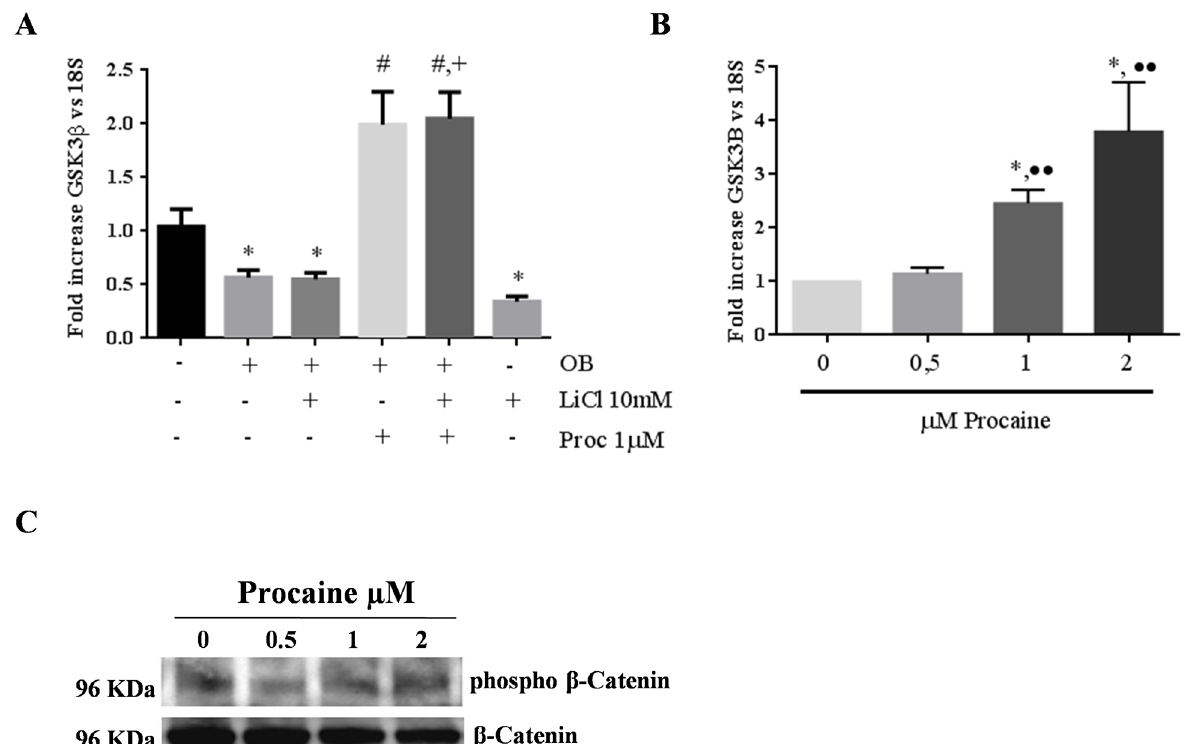
Fig 5. Mechanism of action of procaine. Changes in mRNA expression of GSK3 β from undifferentiated mesenchymal stem cells (UC), MSC differentiated into osteo/odontoblast (OB), MSC differentiated into osteo/odontoblast plus procaine (1 μ M) (OB+Proc), MSC differentiated into osteo/odontoblast plus lithium chloride (10 mM) (OB+LiCl) and the combination of osteo/odontogenic stimuli, Procaine (1 μ M) and Lithium Chloride (10 mM) were analyzed A). Effect of increasing concentrations of Procaine (0, 0.5, 1 and 2 μ M) on GSK3 β expression B) and phospho- β -catenin C) for 7 days on MSC. * p < 0.05 vs UC; # p < 0.05 vs OB; + p < 0.01 vs OB+LiCl; (cid:129)(cid:129) p < 0.01 vs. 0.5 μ M